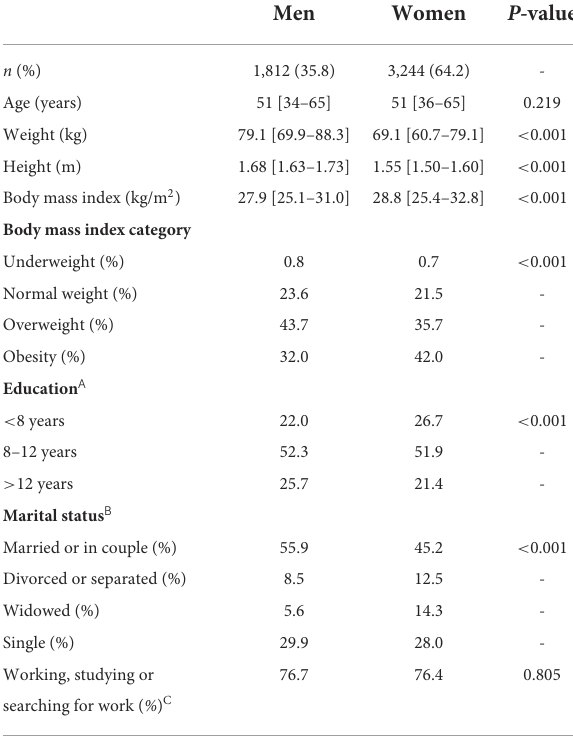
TABLE 1 General characteristics of